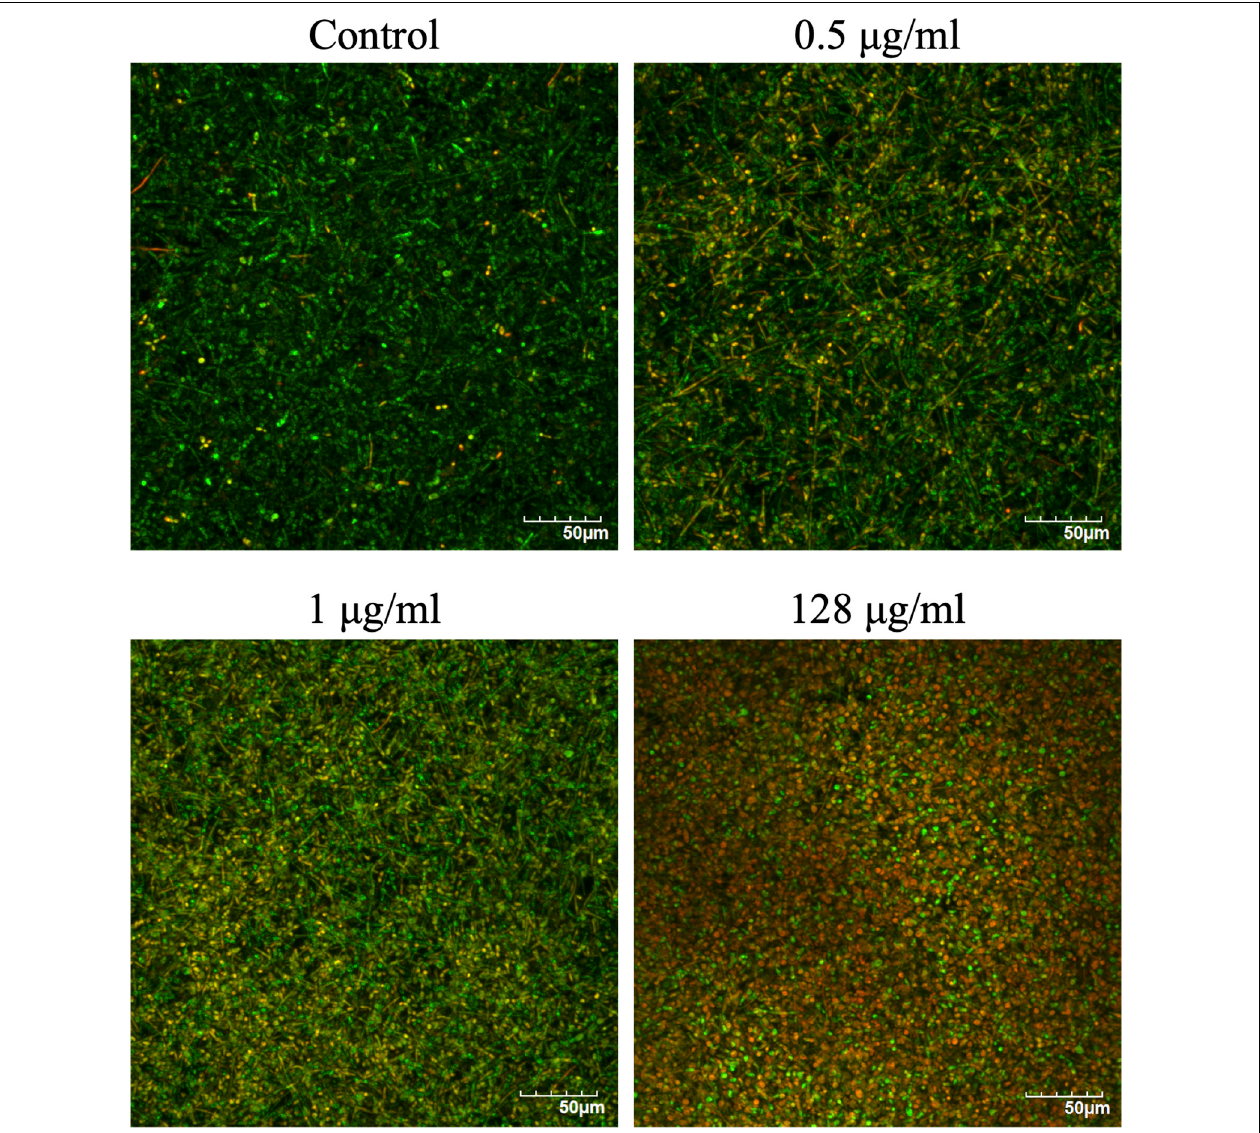
FIGURE 3 | Confocal laser scanning microscopy images of CAS-treated C. albicans biofilms for 24 h. The biofilms were stained with viability indicators (SYTO 9 and propidium iodide). Live cells stain green and dead cells are red/yellow-colored. One representative experiment from two independent ones is shown. Scale bar = 50 µ